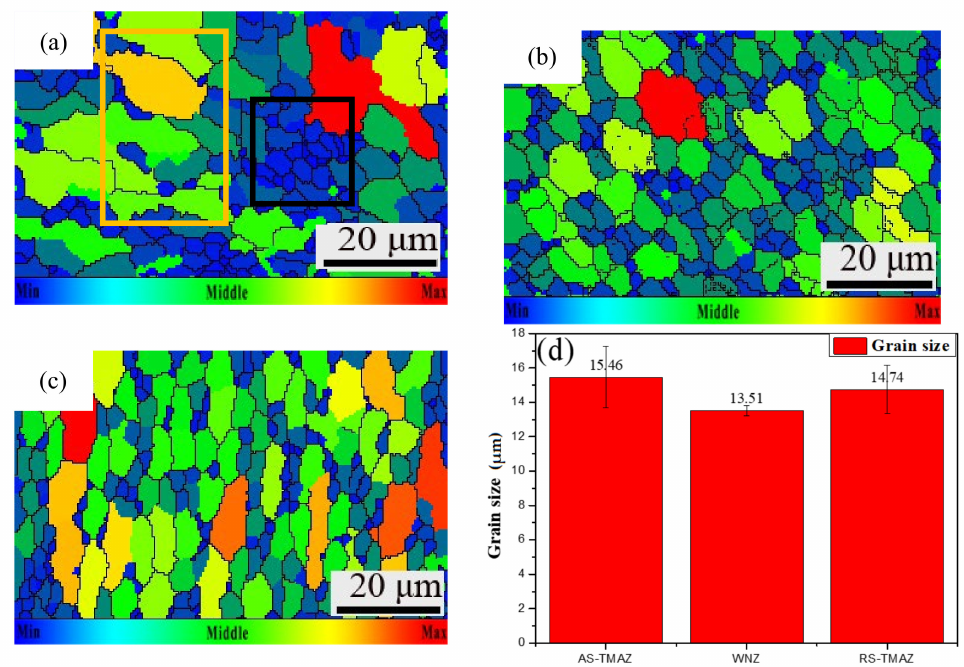
Figure 4. Grain size maps: ( a ) AS-HAZ; ( b ) SZ; ( c ) RS-TMAZ; ( d ) Value of grain size of 7A52 aluminum alloy FSW